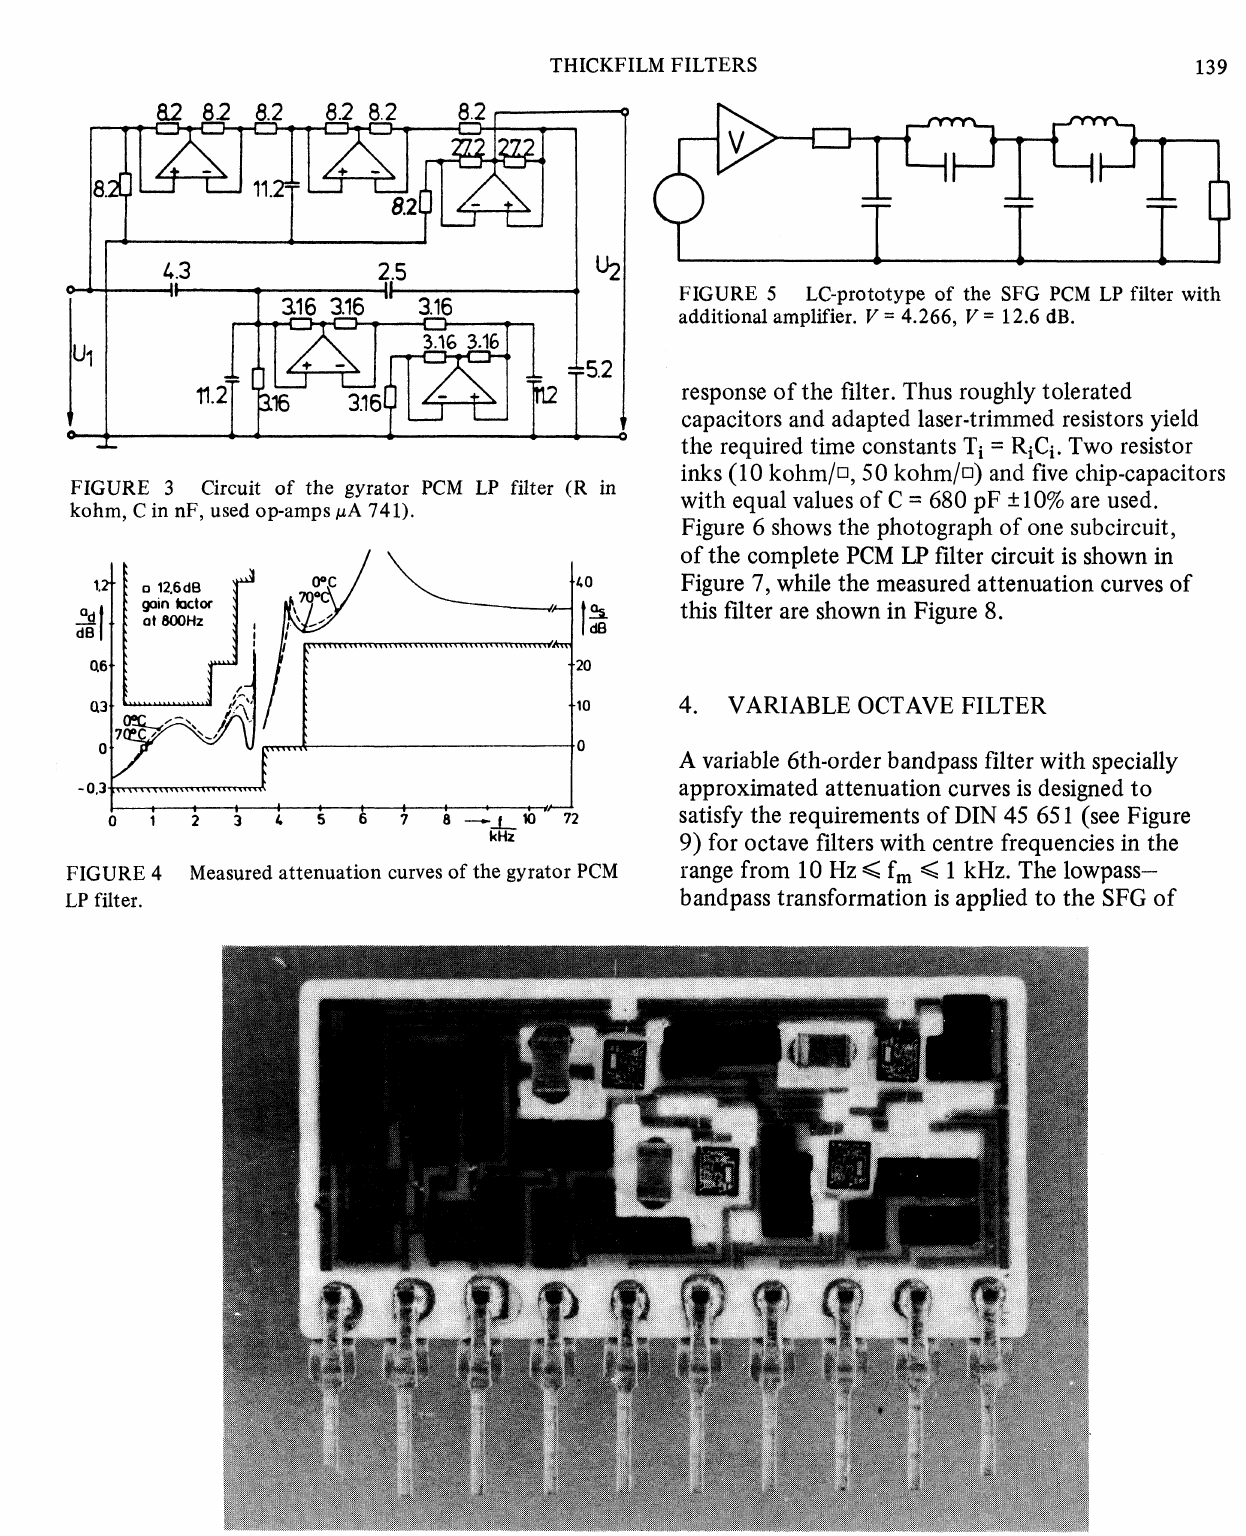
FIGURE 6 Subcircuit for the SFG PCM LP